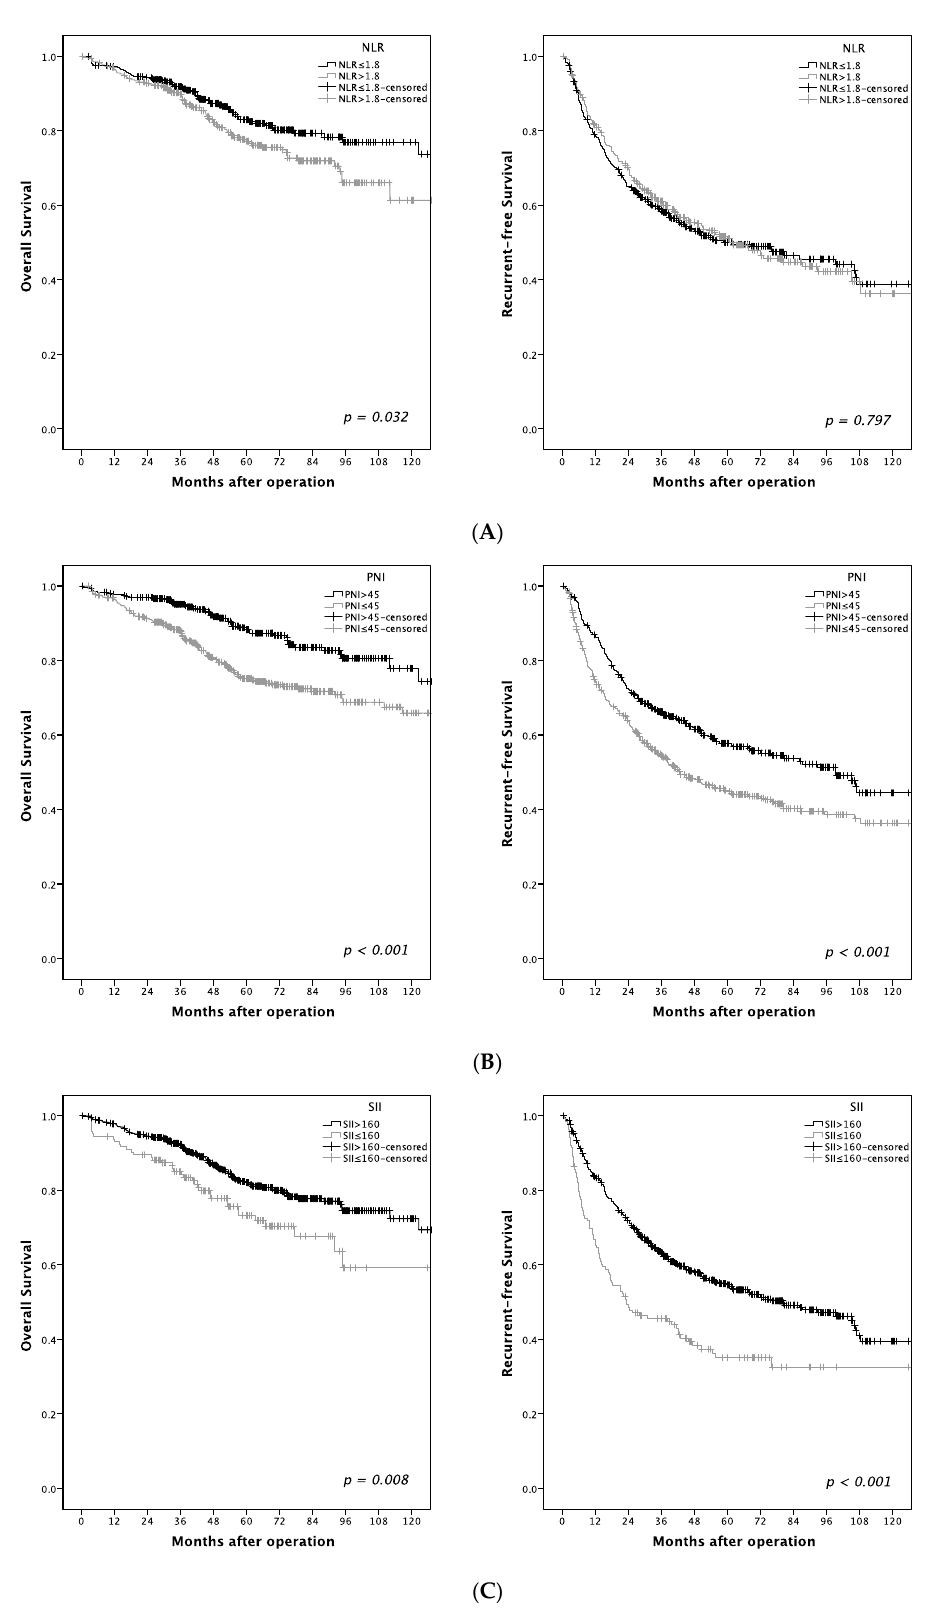
Figure 3. Relationship of ( A ) neutrophil ‐ to ‐ lymphocyte ratio (NLR), ( B ) prognostic nutrition index (PNI), and ( C ) systemic Immune ‐ Inflammation Index (SII) to overall survival (OS), as well as recurrent free survival (RFS).